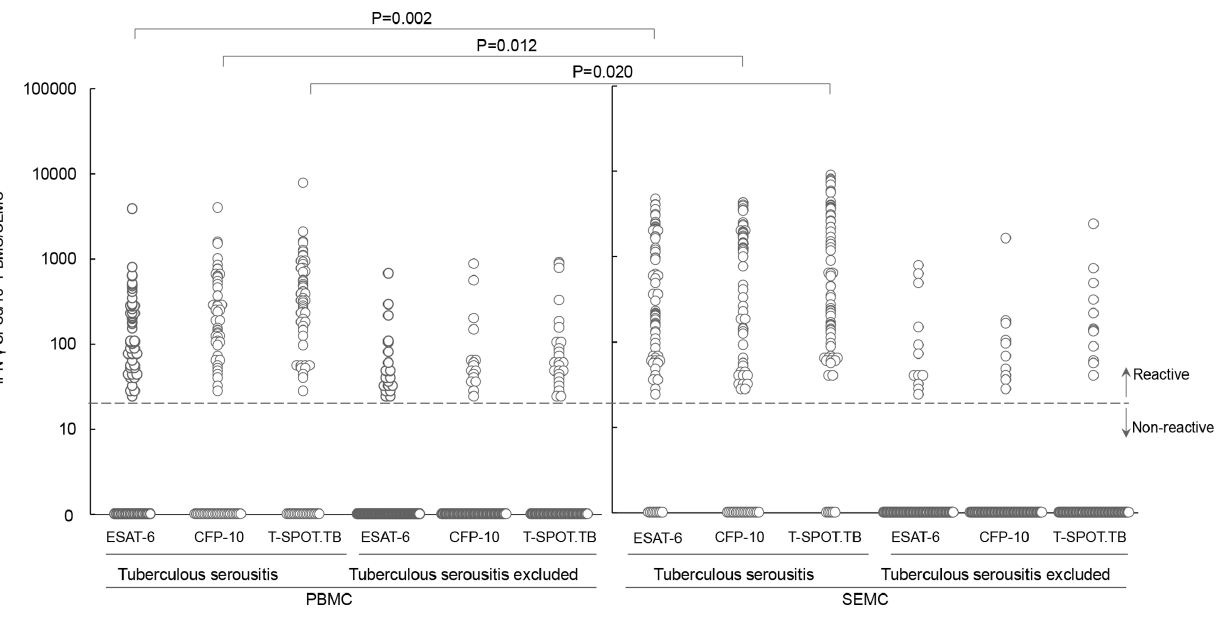
Figure 1. Frequencies of MTB-specific IFN- c secreting T cells in serous effusion and peripheral blood. The frequencies of ESAT-6 and CFP-10 specific IFN- c secreting T cells in SEMC were significantly higher than those in PBMC (P=0.002 for ESAT-6, P=0.012 for CFP-10). The counts of IFN- c secreting T cells specific for CFP-10 appeared higher than ESAT-6, but the difference were not statistically significant (P=0.573 for serous effusion, P=0.092 for peripheral blood). PBMC: peripheral blood mononuclear cell; SEMC: serous effusion mononuclear